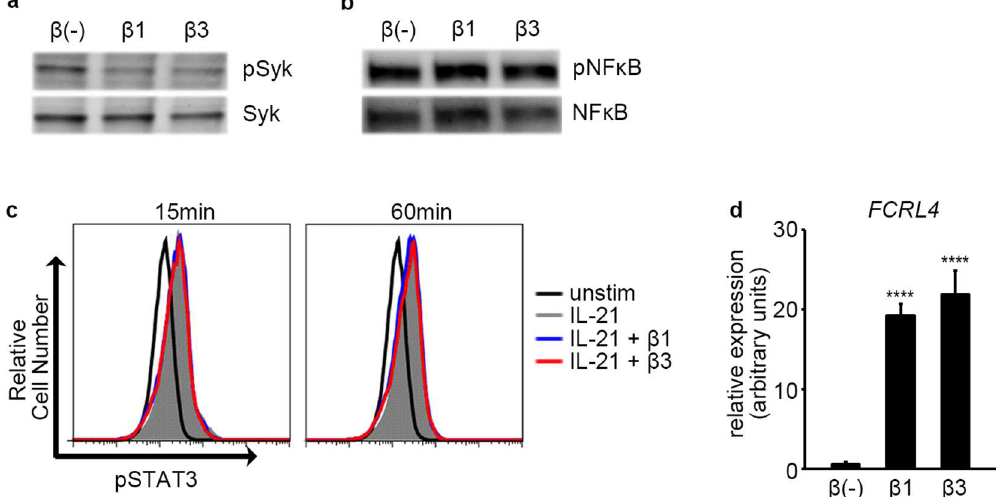
Fig 7. TGF- β 1 and β 3 inhibit phosphorylation of Syk. (a) B cells were culturedovernightwithout TGF- β or with TGF- β , and BCR stimulationwas inducedfor 3 minutes. Results are representativeof three similar experiments. (b) B cells were treated overnight with medium, TGF- β 1, or TGF- β 3 and stimulatedwith IL-21 and sCD40Lfor 3 minutes. Results are representativeof two similar experiments. (c) B cells were treated overnight with medium, TGF- β 1, or TGF- β 3 and stimulatedwith IL-21 for the indicatedtimes. Results are representativeof two similar experiments. (d) B cells were cultured overnight without TGF- β or with TGF- β , and the expressionof FCRL4 was examinedby quantitative PCR. Expression relativeto GAPDH is shown. TGF- β treated cells were comparedwith TGF- β untreated cells using one way ANOVA, Dunnett test (n = 3). Results are representative of two similar